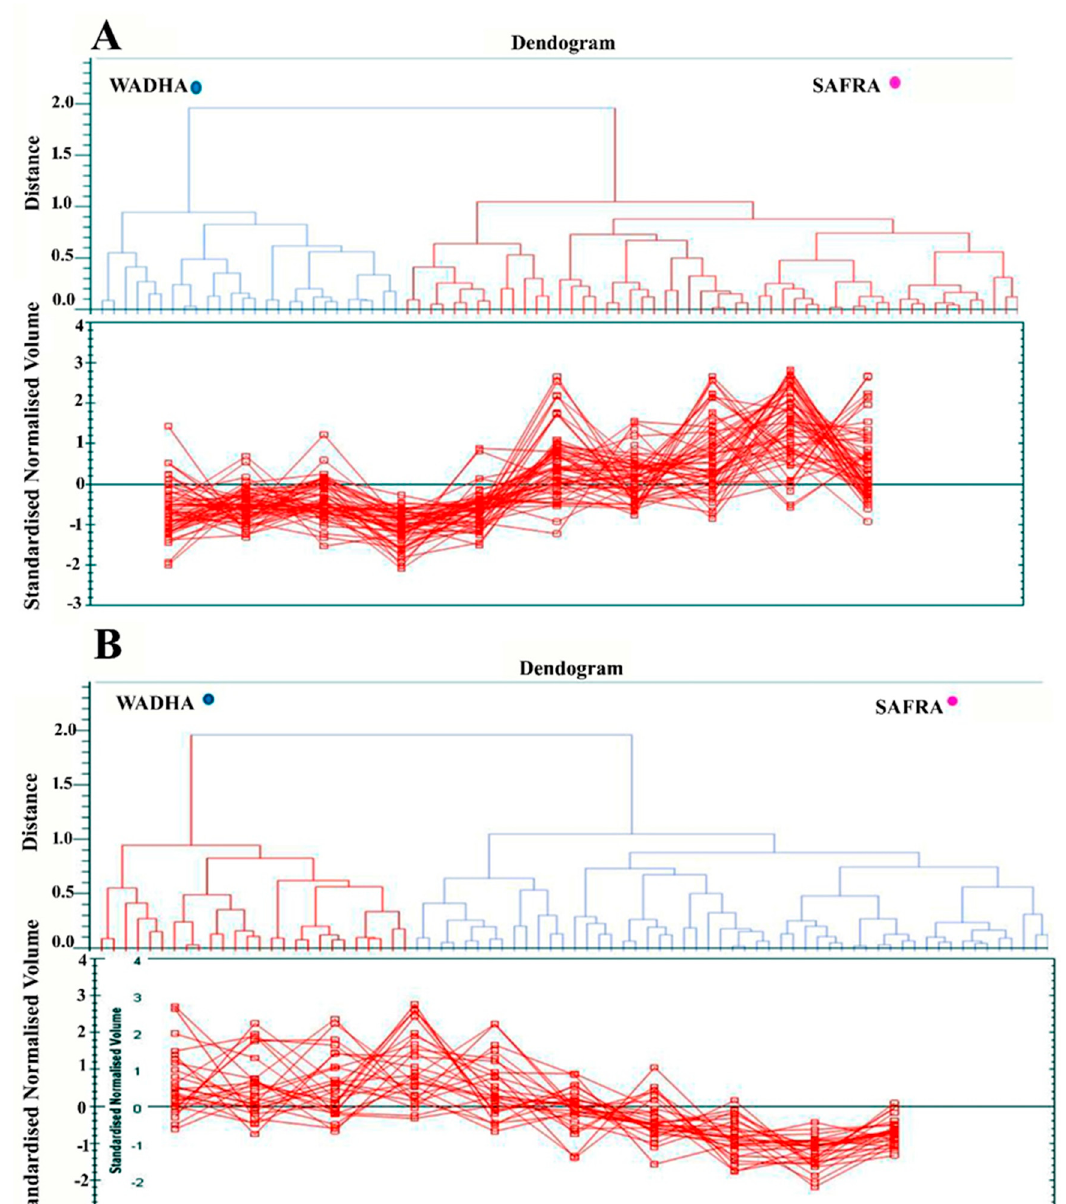
Figure 4. Expression profiles, separated into clusters of expression patterns, indicating the number of spots for each cluster. Each line represents the standardized abundance of a spot across all gels and belongs to one of the clusters generated by hierarchical cluster analysis. ( A ) The spots with increased abundance indicate the 31 proteins up ( B ). The spots with decreased abundance indicate the 13 proteins down in MFGM from Safra breeds compared to Wadha breeds (Progenesis SameSpots).